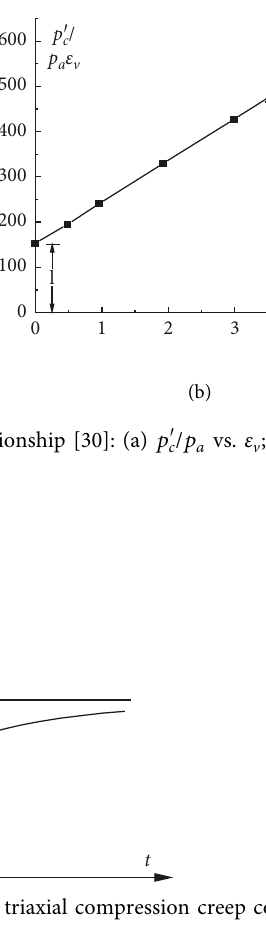
− ε c ′ v relationship [30]: (a)